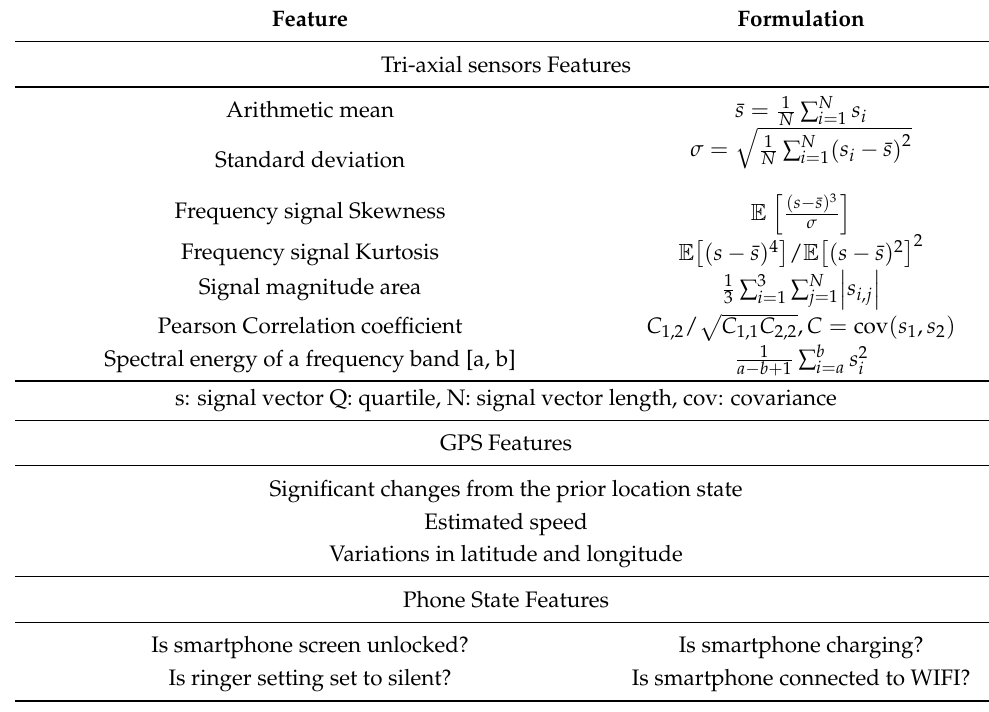
Table 4. A small selection of the handcrafted features applied to accelerometer, gyroscope, and mag- netometer data that we use, taken from Refs.